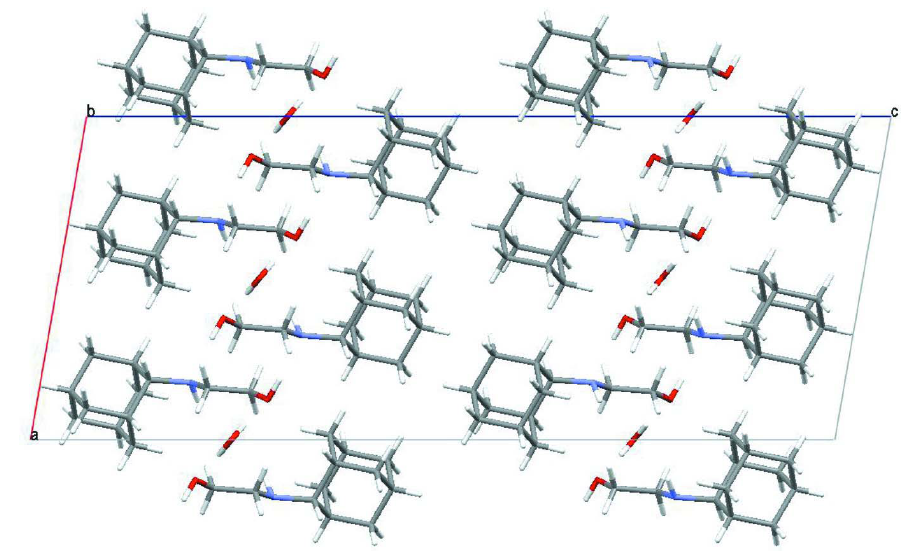
Figure 3 Packing diagram depicting layered structure as seen down the b